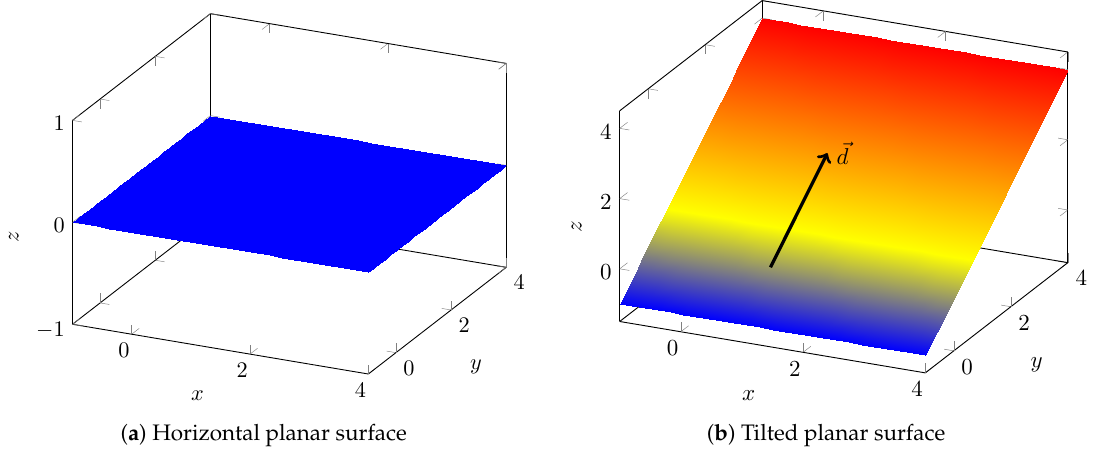
Figure 8. Planar